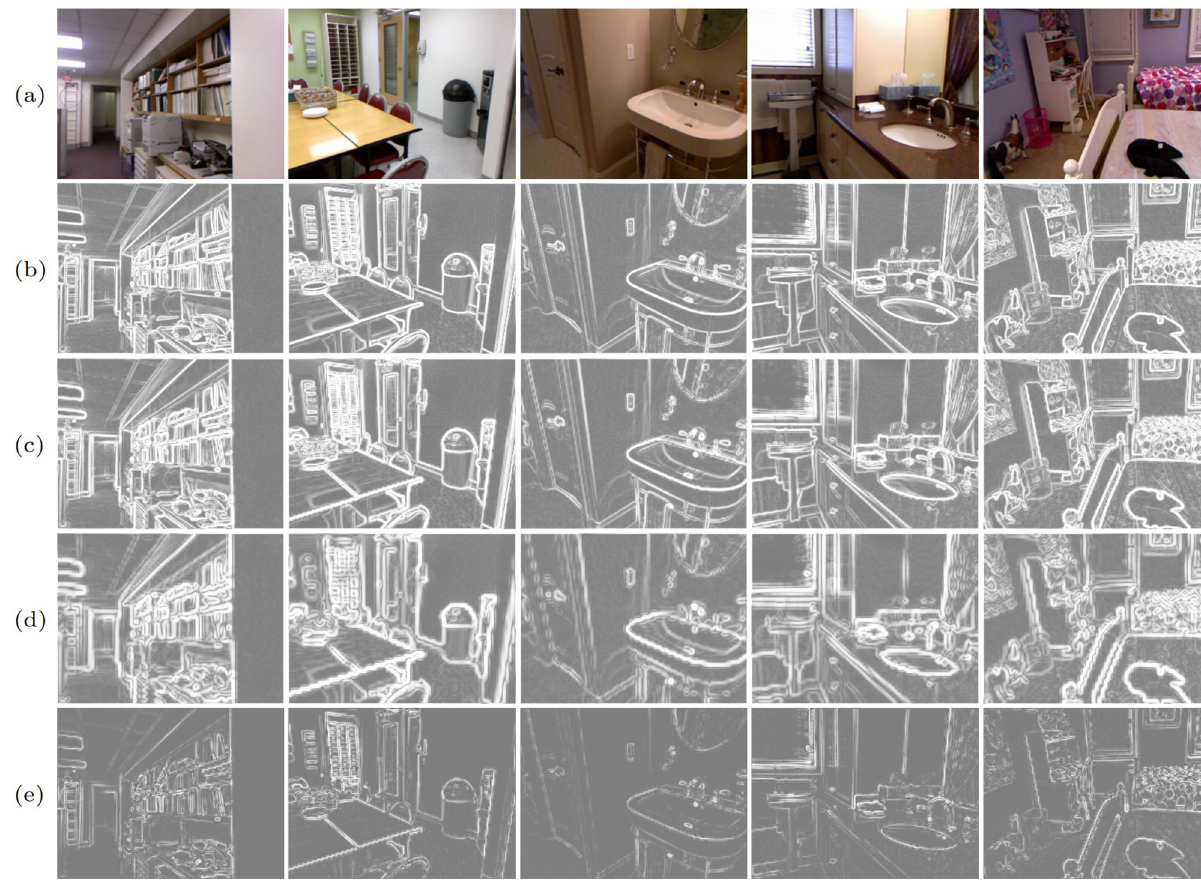
Fig 8. The gradient image analysis of MSGE. (a) RGB, (b) no sampling, (c) 2 × sampling, (d) 4 × sampling, (e) final gradient images.